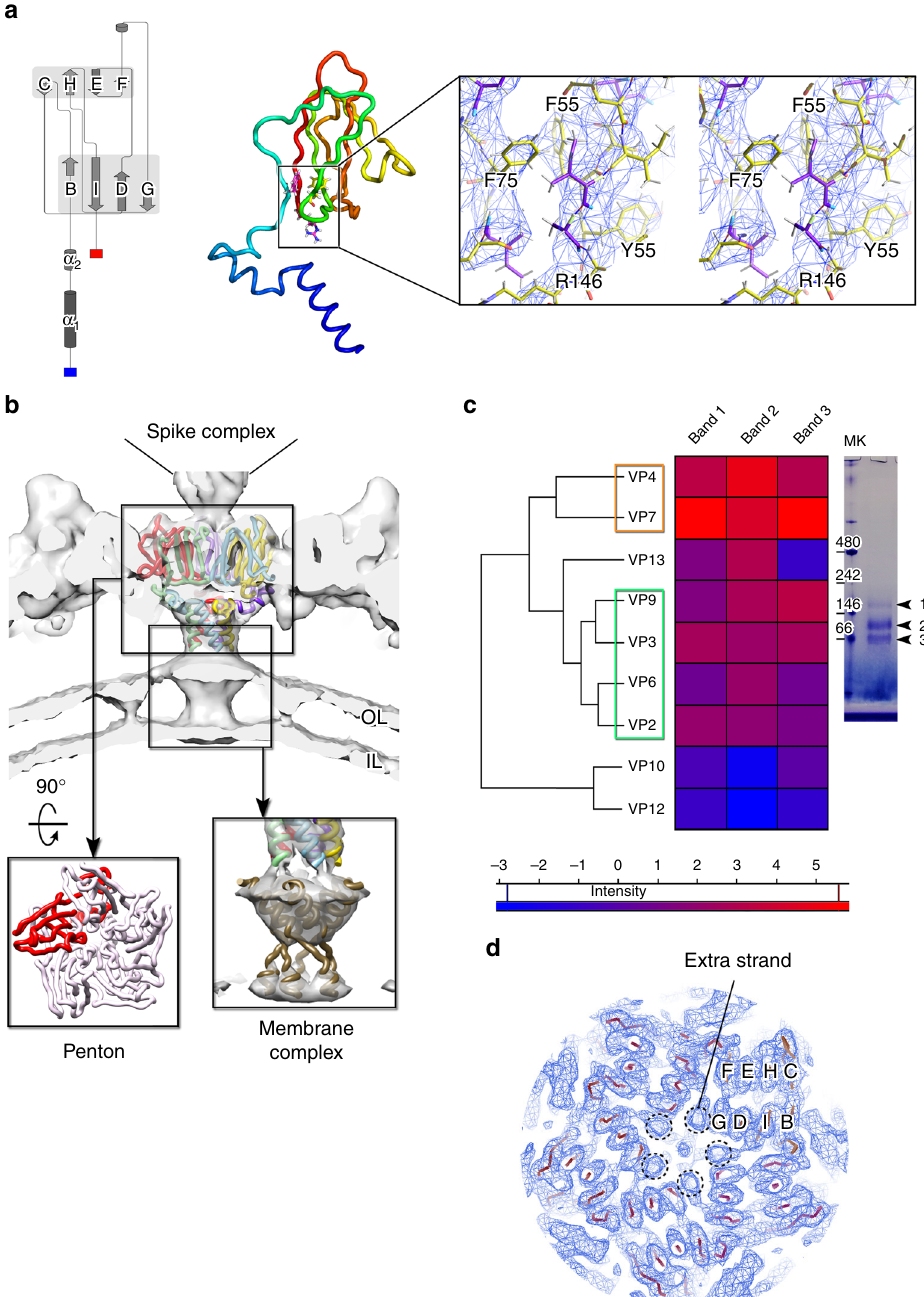
Fig. 4 Interactions at the vertices. a Left, protein structure cartoon of HCIV-1 VP9 penton protein with the labeled jelly-roll strands; center, cartoon-tube representation of VP9 (rainbow coloring: N-terminus, blue; C-terminus, red) with inset showing a stereoview of the corresponding electron density region (as in Fig. 1b inset) marked by the black rectangle with in stick the residues F55, F75, Y55, and R146. b Five copies of VP9 models (yellow, magenta, cyan, green, and red) fi tted into the corresponding HCIV-1 cryo-EM map (solid white and Gaussian fi ltered with 2.8 Å width) viewed perpendicular to the icosahedral fi ve-fold axis. Inset on the left, view of the penton complex from the top (one VP9 subunit in red tube, the remaining four in white); inset on the right, the density region corresponding to the membrane protein plugging the membrane vesicle fi ve-fold apices (contoured at higher threshold) and compatible with fi ve copies of the C-terminal transmembrane helix of VP13 (brown tube; see below, Methods and Supplementary Figure 9a-b). c Heatmap depicting the hierarchical clustering (dendrogram on the left) where rows indicate the viral proteins detected according to their normalized abundance factor (NSAF) across the columns which represent the gel bands (arrowheads 1, 2, 3) cut from the representative native gel on the right (MK, markers in kDa). Color scale represents the intensity values as de fi ned as I = log2 (NSAF) with blue = low abundance, red = high abundance. The orange and green rectangles mark, respectively, the clustering of the MCPs and the proteins composing the vertex complex with identi fi ed VP13 grouping closer to the vertex complex whereas proteins VP10 and VP12 are almost equidistant from the two major clusters. d View of the cryo-EM map as blue mesh (contoured as in Fig. 1b inset) viewed along the fi ve-fold symmetry axis with fi tted the C α model of the penton in red and with one VP9 jelly-roll labeled as in a left; the dashed black circles mark the extra β -strands deriving from the above spike complex and that interact with the VP9 G